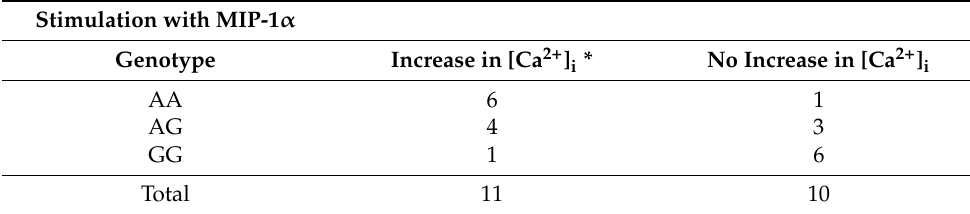
Table 2. [Ca 2+ ] i upon stimulation with MIP-1 α in patients with Löfgren’s syndrome according to rs1799987 genotypes.